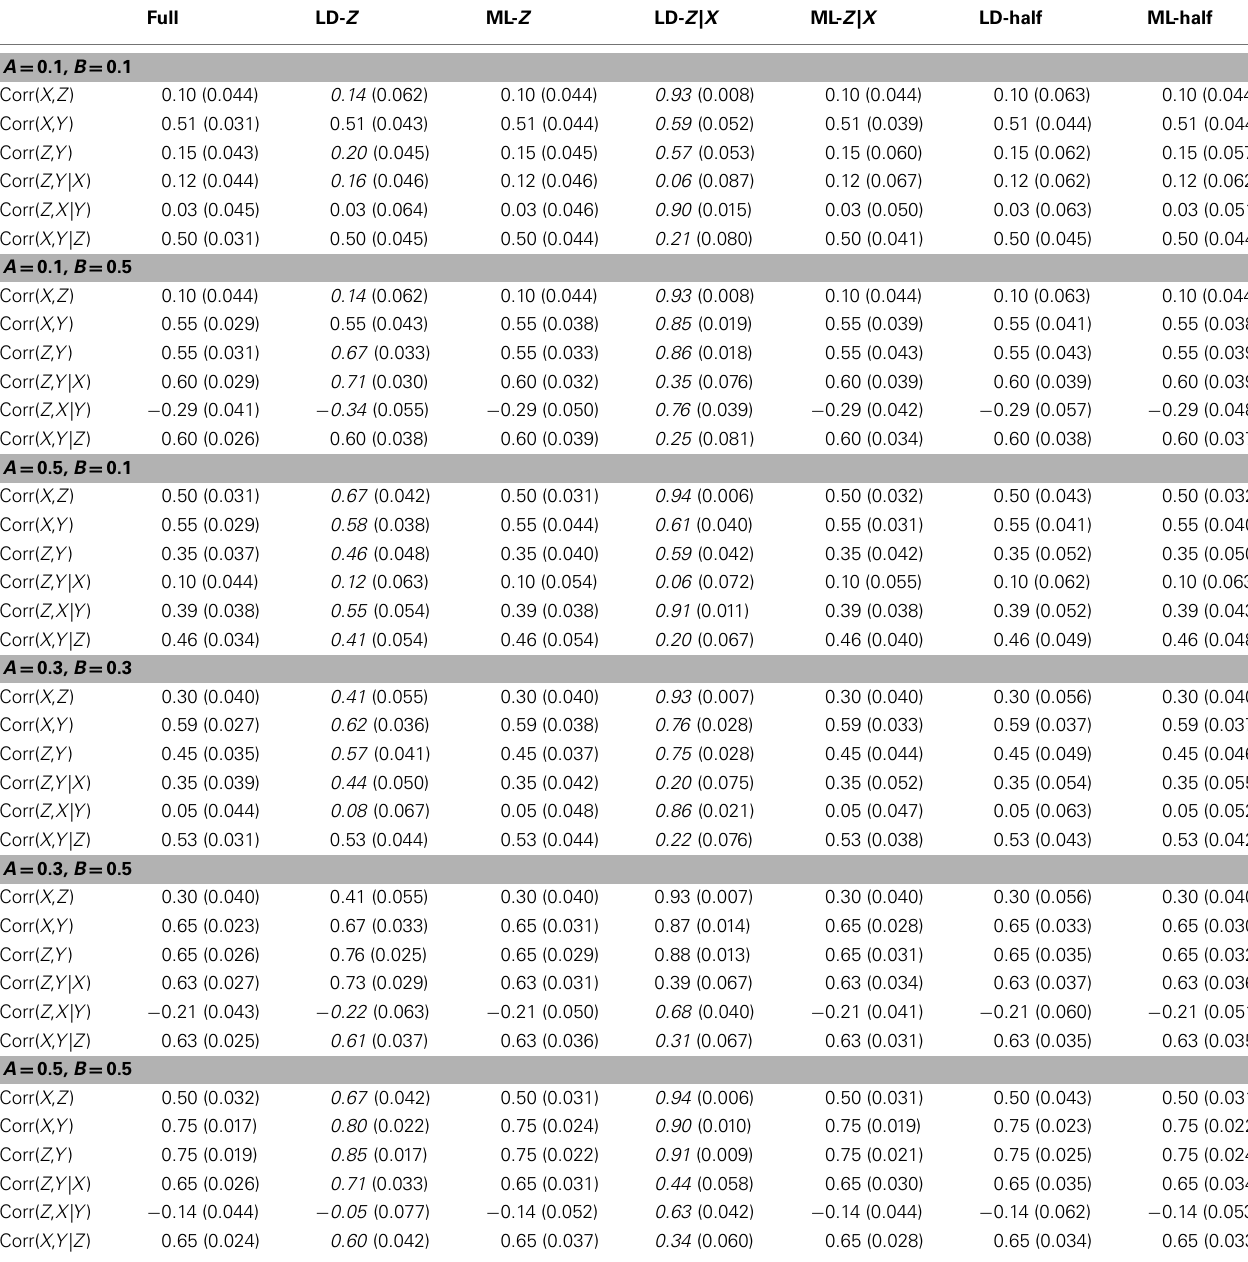
Table 4 | Estimates and their SD for correlations and partial correlations across various mediation (non-null) situations ( N = 500). Full LD- Z ML-